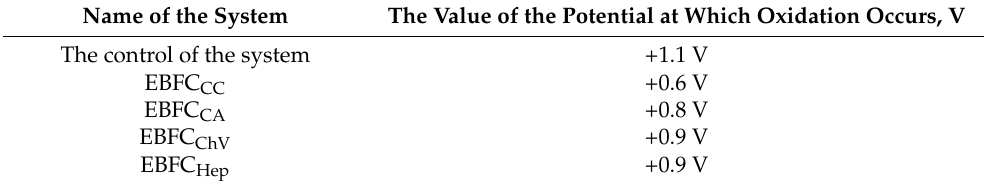
Table 1. The summary of values of the potential at which oxidation occurs on EBFC CC , EBFC CA , EBFC ChV , and EBFC Hep electrodes.